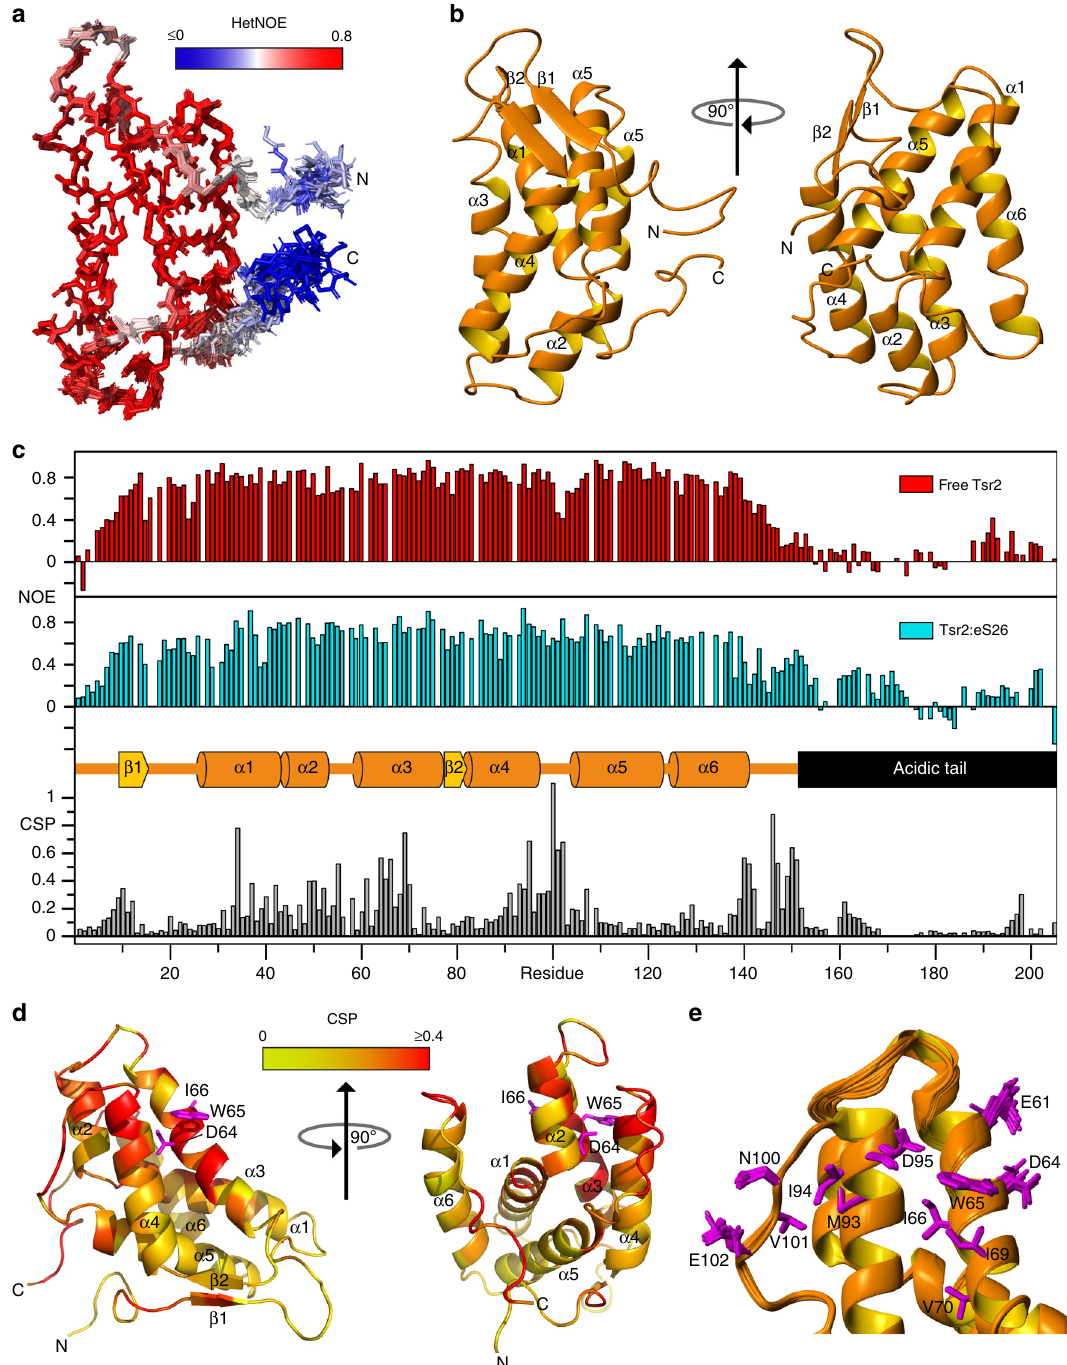
Fig. 2 Structure of Tsr2-N and in complex with eS26 revealed by NMR. a Superposition of the 20 lowest-energy conformers representing the NMR solution structure of Tsr2-N after energy-minimization with AMBER. The N- and C-termini are indicated with N and C, respectively. The color coding re fl ects the conformational mobility of individual backbone amides derived from the { 1 H} 15 N NOE experiment and ranges from blue to red for fl exible and rigid moieties, respectively. b Cartoon representation of Tsr2-N with labels indicating α -helices and β -strands. c Upper panel: { 1 H} 15 N NOE data of full-length Tsr2 in the absence and presence eS26. Lower panel: The combined 1 H and 15 N chemical shift perturbation (CSP) of full-length Tsr2 upon binding to eS26. Secondary structure boundaries of Tsr2-N as well as the acidic tail region are indicated in the center. d CSP data from c visualized on a cartoon representation of the lowest-energy conformer of Tsr2-N. The color coding re fl ects the perturbation of individual amide resonances and ranges from yellow (CSP = 0 ppm) to red (CSP ≥ 0.4 ppm). Sidechains of residues D64, W65, and I66 are shown. e Sidechains of residues with a particularly large CSP are indicated in magenta on a cartoon representation of the ensemble of 20 Tsr2-N